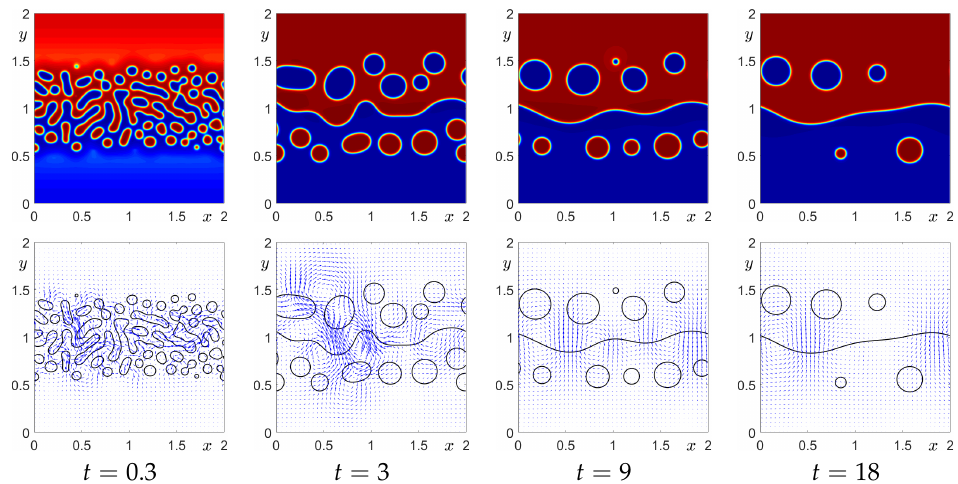
t = 0.3 t = 3 t = 9 t = 18 Figure 6. The top and bottom rows display the snapshots of φ and velocity field for nucleation process. The computational moments are illustrated under each figure.